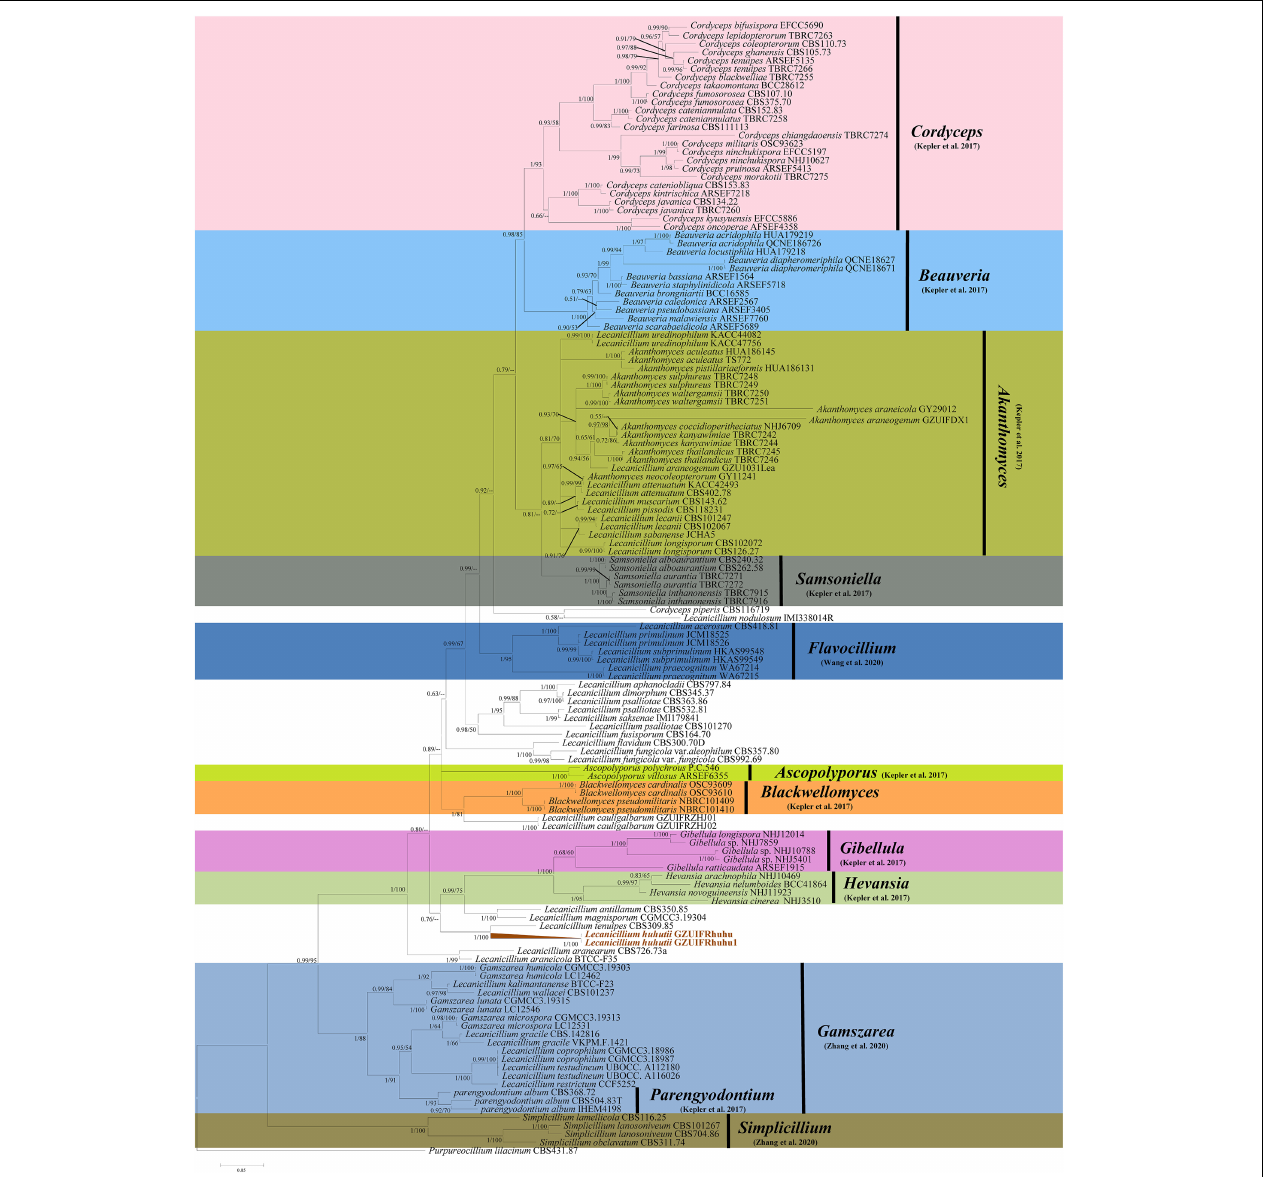
FIGURE 1 | Phylogenetic relationships of the form genera Lecanicillium , Cordyceps , Beauveria , Akanthomyces , Samsoniella , Flavocillium , Ascopolyporus , Blackwellomyces , Gibellula , Hevansia , Gamszarea , Parengyodontium , and Simplicillium in the family Cordycipitaceae. Numbers near the nodes (bootstrap percentage values) correspond to the Bayesian posterior probabilities (BPP) and the ML methods. Bootstrap percentage values are based on 1,000,000 replicates and only the bootstrap proportions ≥ 0.50 are provided. ML values < 50% are shown as “–.” The tree is drawn to scale, with branch lengths in the same units as those of the evolutionary distances used to infer the phylogenetic